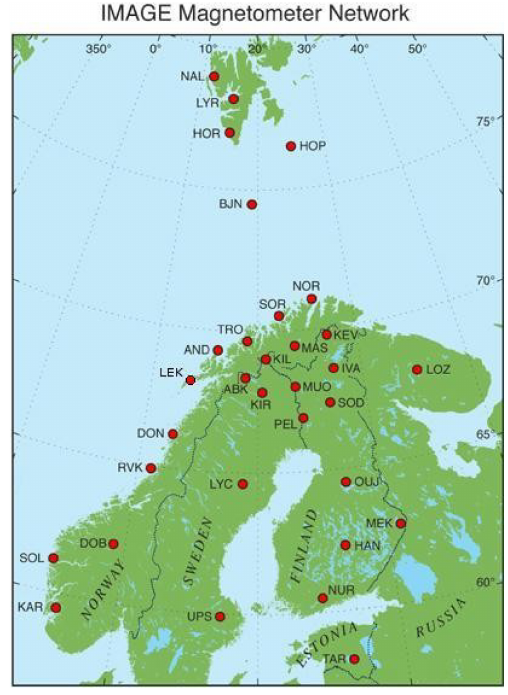
Fig. 1. Map of the IMAGE magnetometer